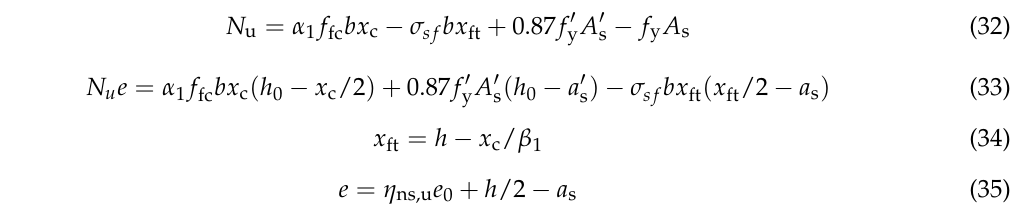
tested yield strength ( f y and f y (cid:48) ) of the longitudinal steel bars into the above equations, the ultimate axial force of the SFRC-RA columns are able to be obtained, as listed in Table 10. The ratio of